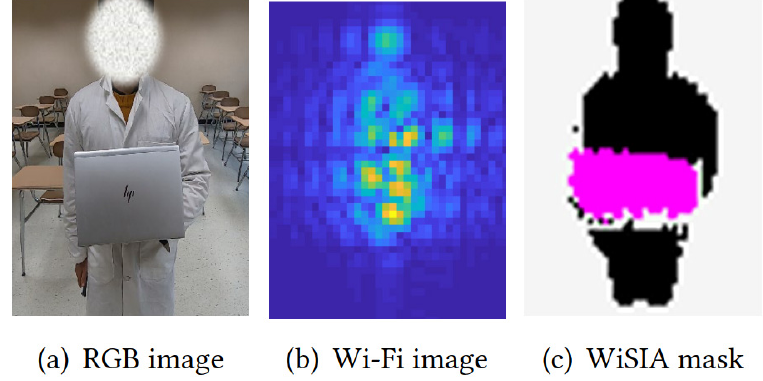
Figure 6. Example imaging results that were produced by WiSIA [50].